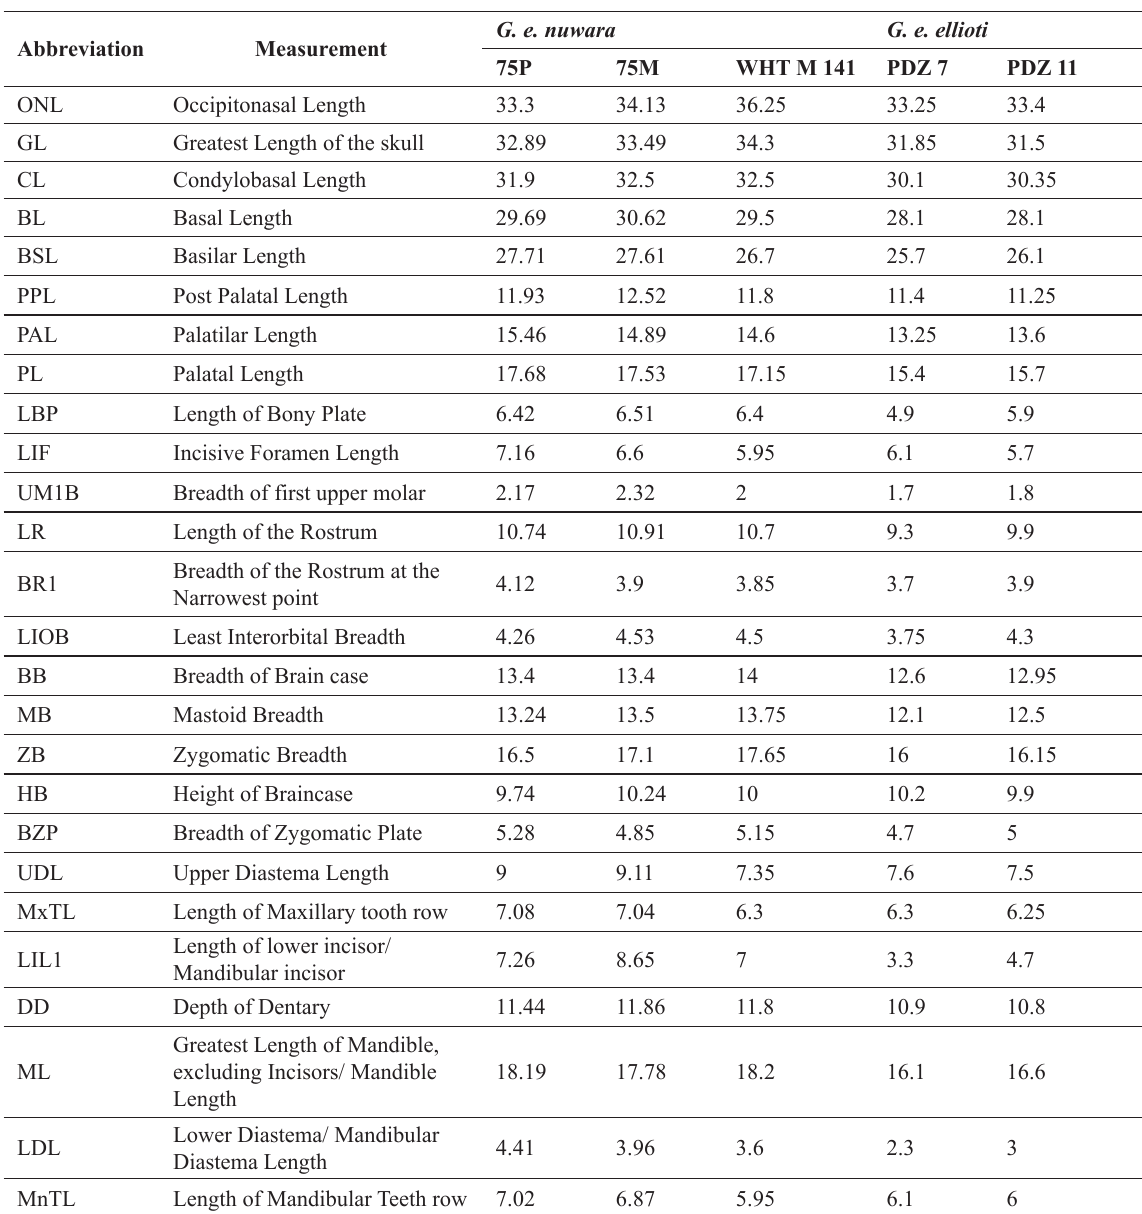
Table 4: Skull measurements (mm) of Golunda ellioti nuwara and G. e.